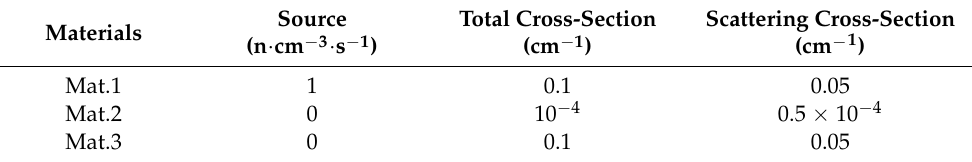
Figure 2. Geometry of the self-designed neutron streaming problem. Table 1. Source strength and cross-sections of the self-designed neutron streaming